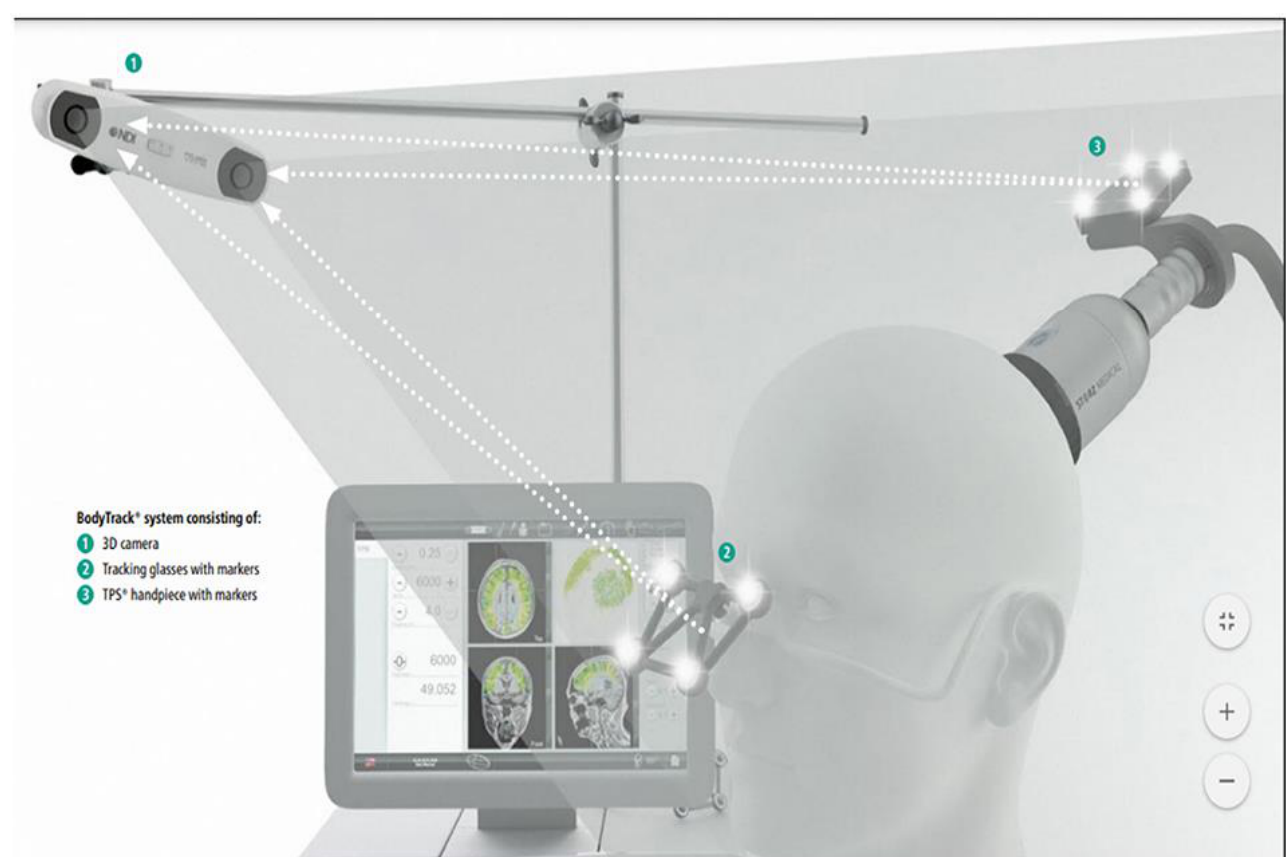
Figure 2. Courtesy image from NEUROLITH — TPS MANUFACTURER.